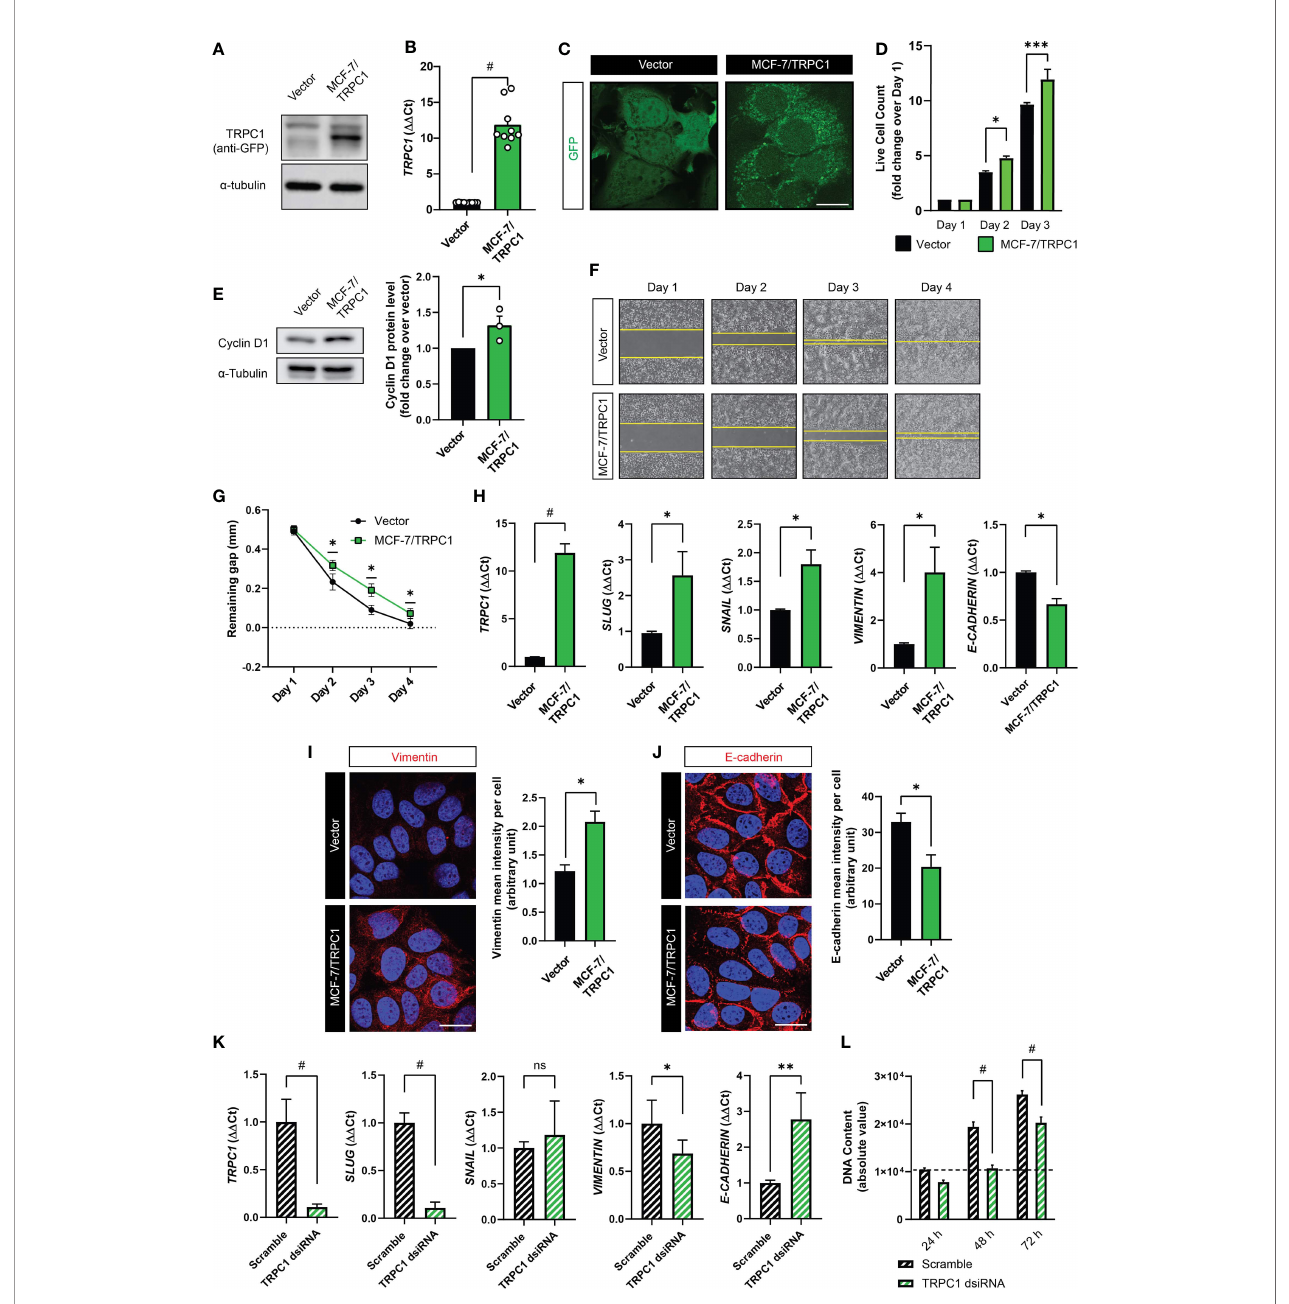
FIGURE 6 | Characterization of TRPC1 overexpressing MCF-7 cell line. (A) Western analysis showing the overexpression of GFP-TRPC1 in MCF-7 cells, detected using anti-GFP antibody. (B) Quanti fi cation of DD Ct fold change of TRPC1 transcript levels in MCF-7/TRPC1 cells (green) and vector-transfected cells (black). (C) Fluorescence images showing GFP and GFP-TRPC1 in vector and MCF-7/TRPC1 cells, respectively. Scale bar = 10 µm. (D) Live cell counts for MCF-7/TRPC1 (green) and vector-transfected (black) cells over 3 days. (E) Western analysis showing Cyclin D1 protein levels 24 h post-seeding. (F) Representative images of cell migration over 4 days. Stable cells were seeded at a density of 30,000 per well one day before the removal of the insert to create a 0.5 mm gap. (G) Gap remaining over 4 days of the migration assay. (H) Transcript levels of TRPC1 , SLUG , SNAIL , VIMENTIN , and E-CADHERIN in vector (black) and MCF-7/TRPC1 (green) cells. Representative confocal images of vector and MCF-7/TRPC1 cells stained for Vimentin (I) and E-Cadherin (J) alongside corresponding histograms of mean intensity per cell. Absolute fl uorescence intensity was normalized to the total number of nuclei per view. Scale bar = 10 m m. (K) Transcript levels for TRPC1 , SLUG , SNAIL , VIMENTIN , and E-CADHERIN in scrambled- (black hatched) and TRPC1-silenced (green hatched) cells. (L) Proliferation over 3 days for TRPC1 -silenced cells relative to scramble RNA-transfected cells. TRPC1 silencing was achieved using 2 independent dsiRNAs and the bar charts show the respective quanti fi cation of the pooled data. All results were from 3 to 5 independent experiments with * p < 0.05, ** p < 0.01, *** p < 0.001 and # p < 0.0001. The error bars represent the standard error of the mean. “ ns ” indicates statistically nonsigni fi cant